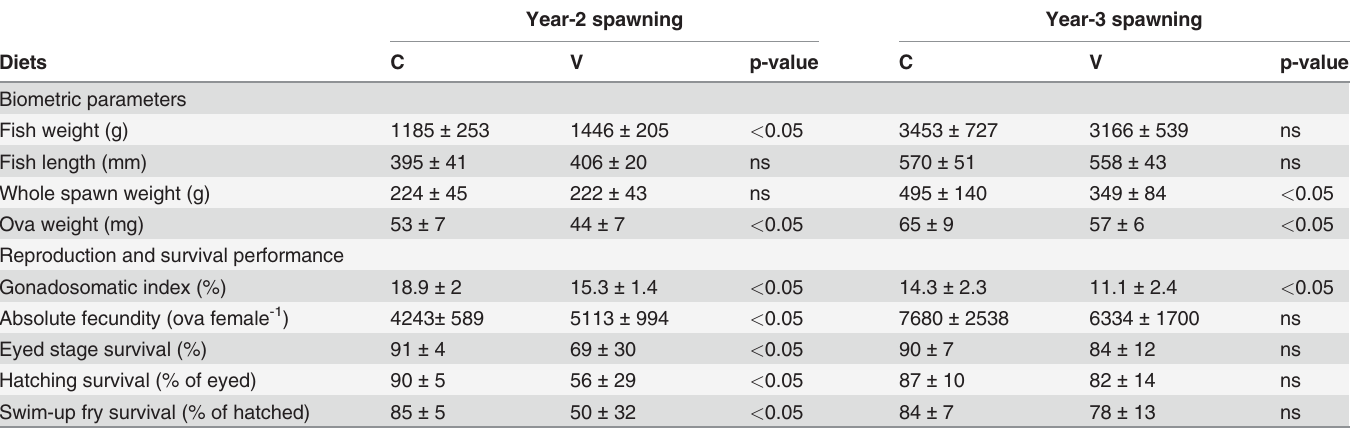
Table 3. Biometric parameters, reproduction performance and survival rates.